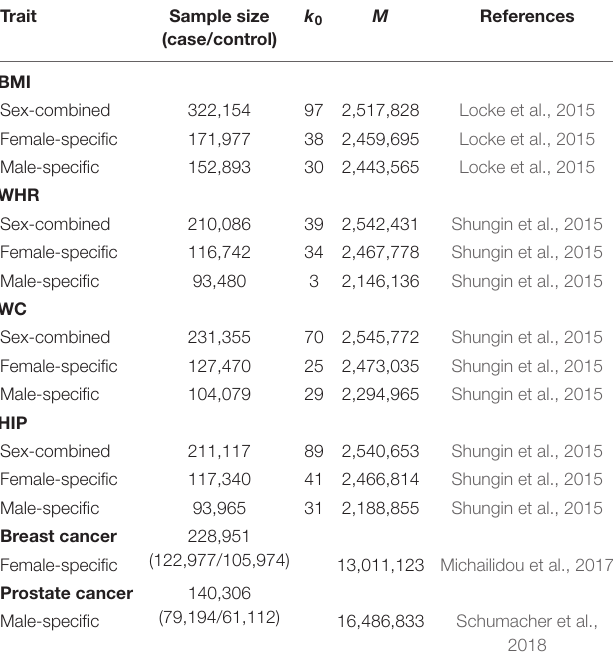
TABLE 1 | Genetic variants with significant sex difference in effect size for four anthropometric traits. Traits Gene CHR POS SNP Effect P Q Folds